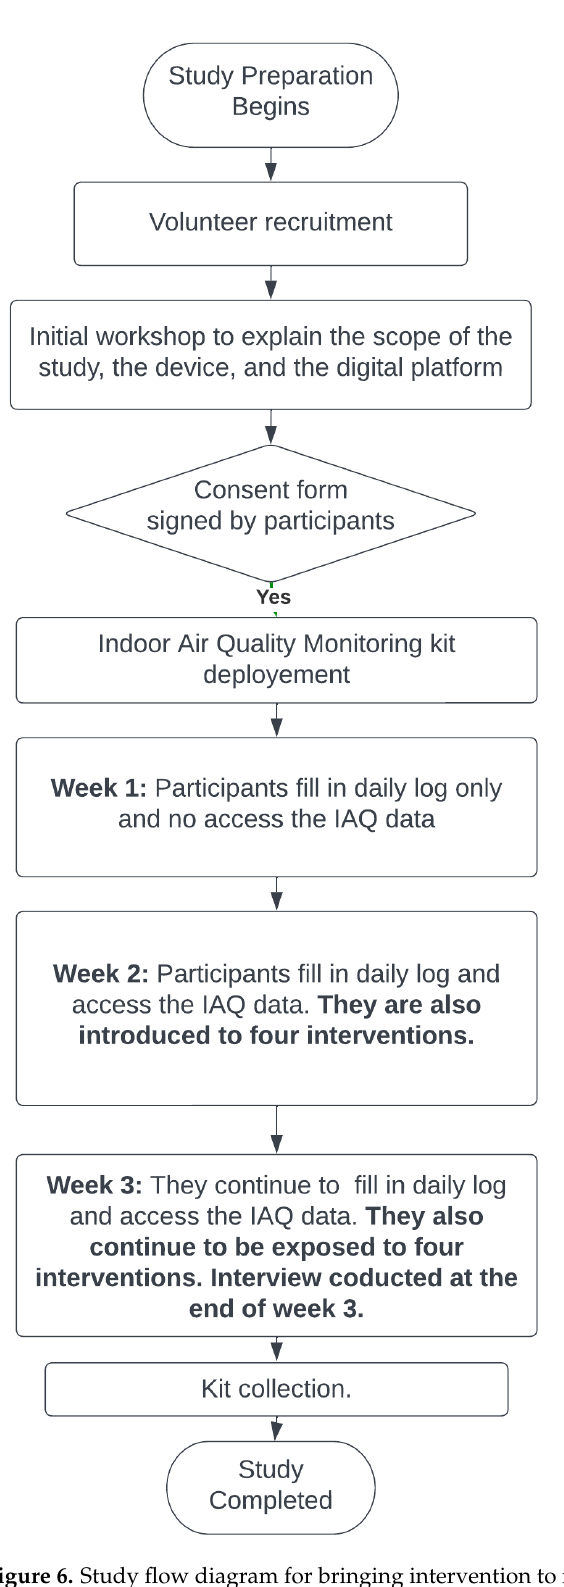
Figure 6 . Study flow diagram for bringing intervention to raise awareness about IAQ . Figure 6. Study flow diagram for bringing intervention to raise awareness about